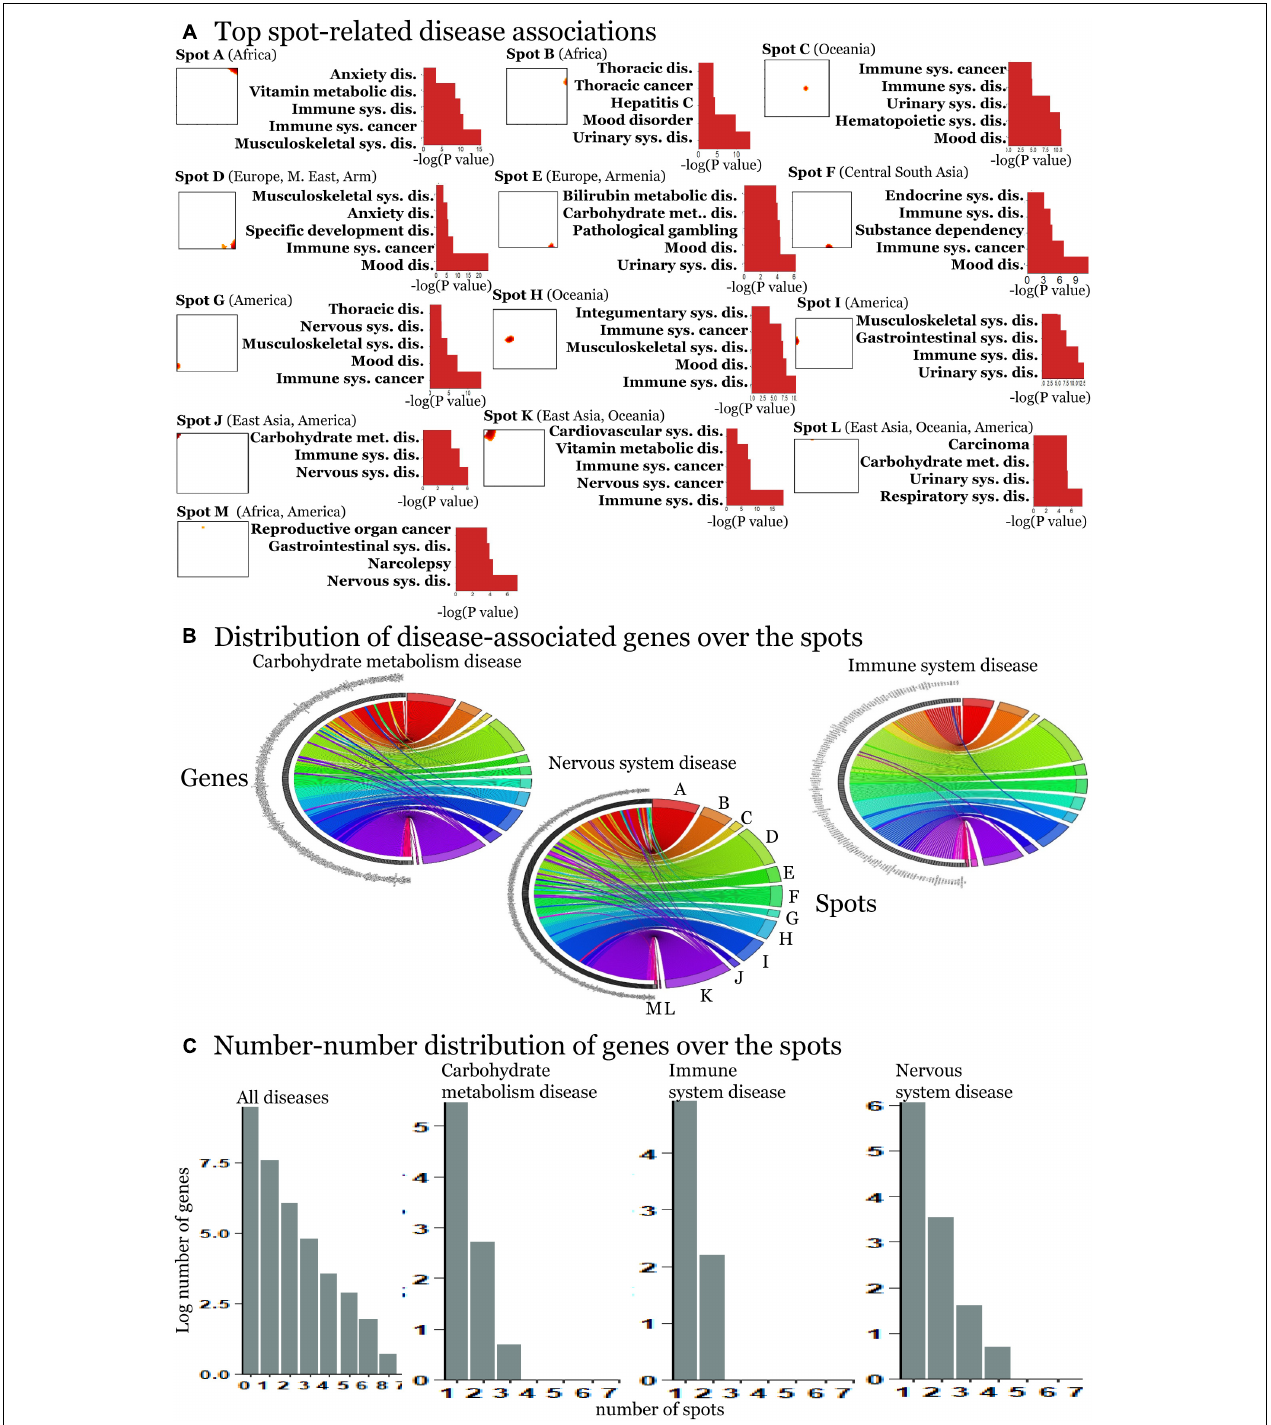
FIGURE 4 | Spot-enrichment of disease-associated SNPs. (A) Top enriched disease terms in each of the spots (see Supplementary Figures S7 – S19 for full lists of enriched diseases and Supplementary Figures S5 , S6 for their background distribution). Enrichment p -values are obtained using Fishers exact test. (B) The circular plots link genes with spot-clusters containing SNPs referring to these genes. Each circular plot shows SNPs which associate with one disease. Different genes which associate with the same disease distribute over different spots. Genes specifically accumulate in the spots in a one-to-one fashion as a rule of thumb. Only a few genes were found in two or more spots according to different SNPs in the same gene (e.g., SH2B3). Examples were shown for three selected disease classes. (C) The number–number distributions over the spots follow an exponential decay meaning that the majority of genes associates with a single spot.